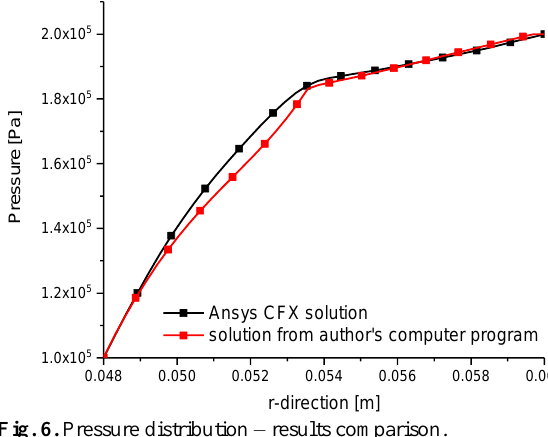
Fig. 6. Pressure distribution – results